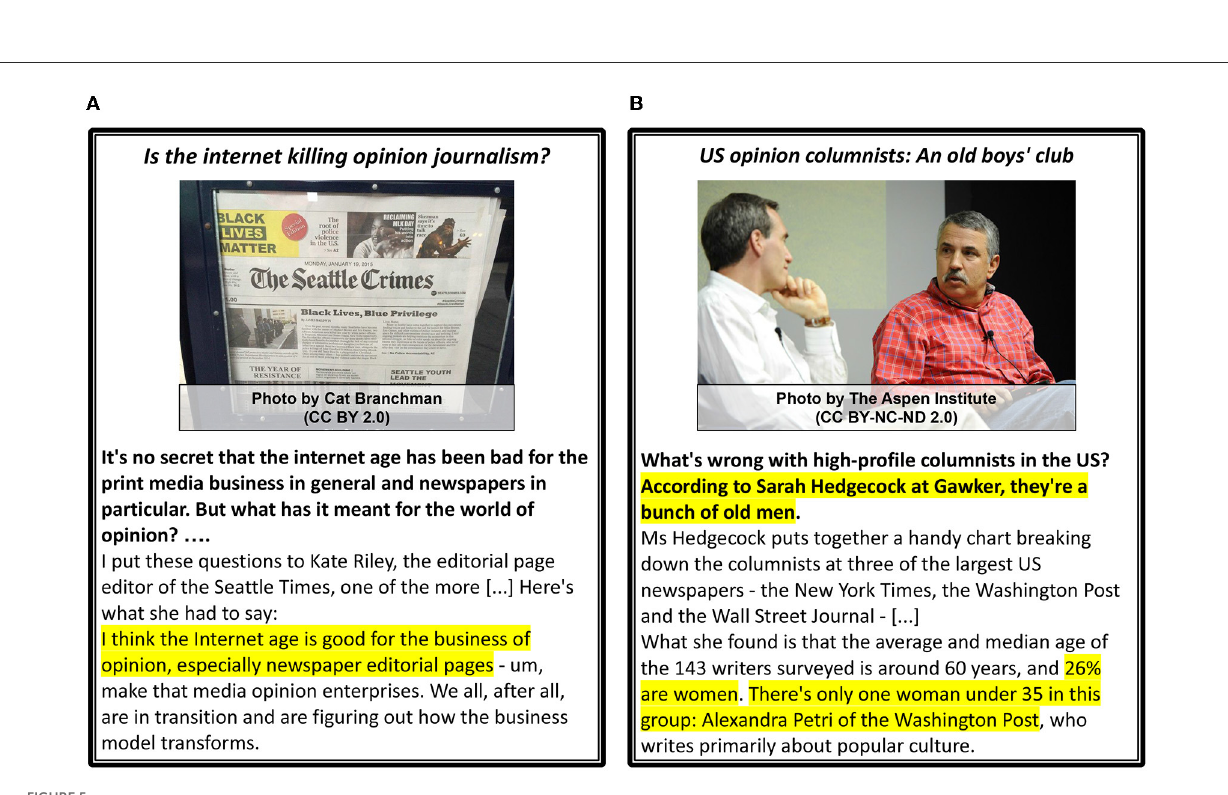
FIGURE5 Author Intent examples for Persuasive–Promotive and Persuasive–Demotive. The portions of the text that lead to the assignment of corresponding categories are highlighted (yellow). (A) Promote. (B)